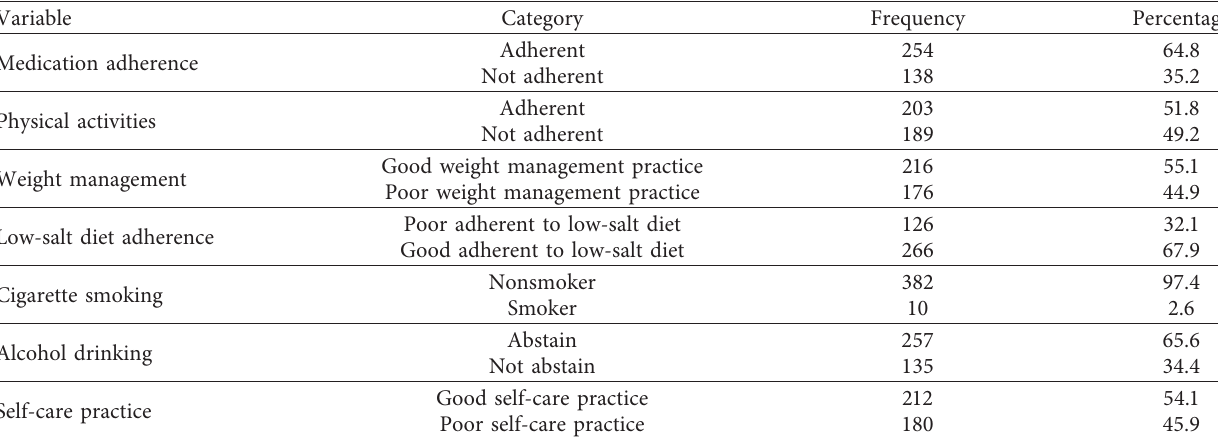
Table 5: Self-care practices of hypertensive patients at Debre Tabor Referral Hospital, Northwest Ethiopia, 2020.